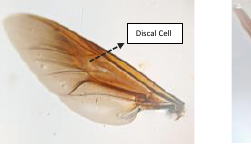
Figure 11: Wings of the captured fly where discal cell can be seen in the middle